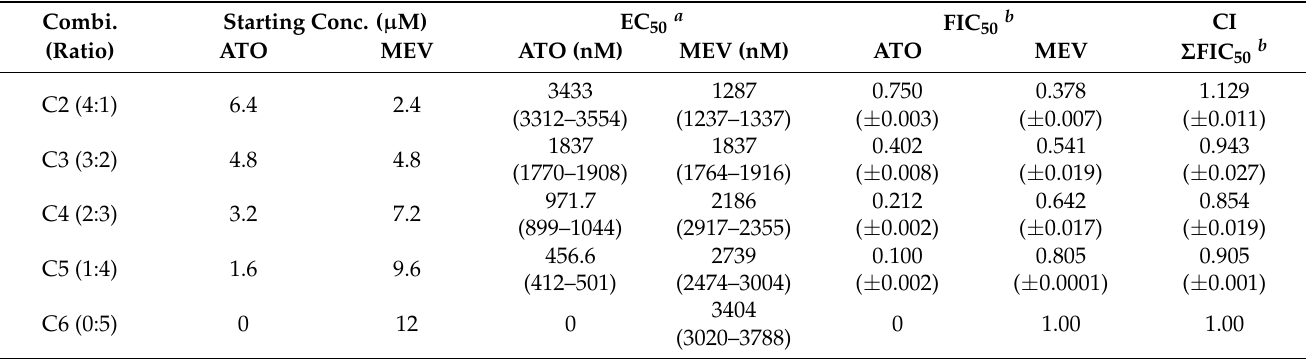
Table 1. Half-maximal inhibitory concentrations of the atorvastatin and mevastatin combinations.